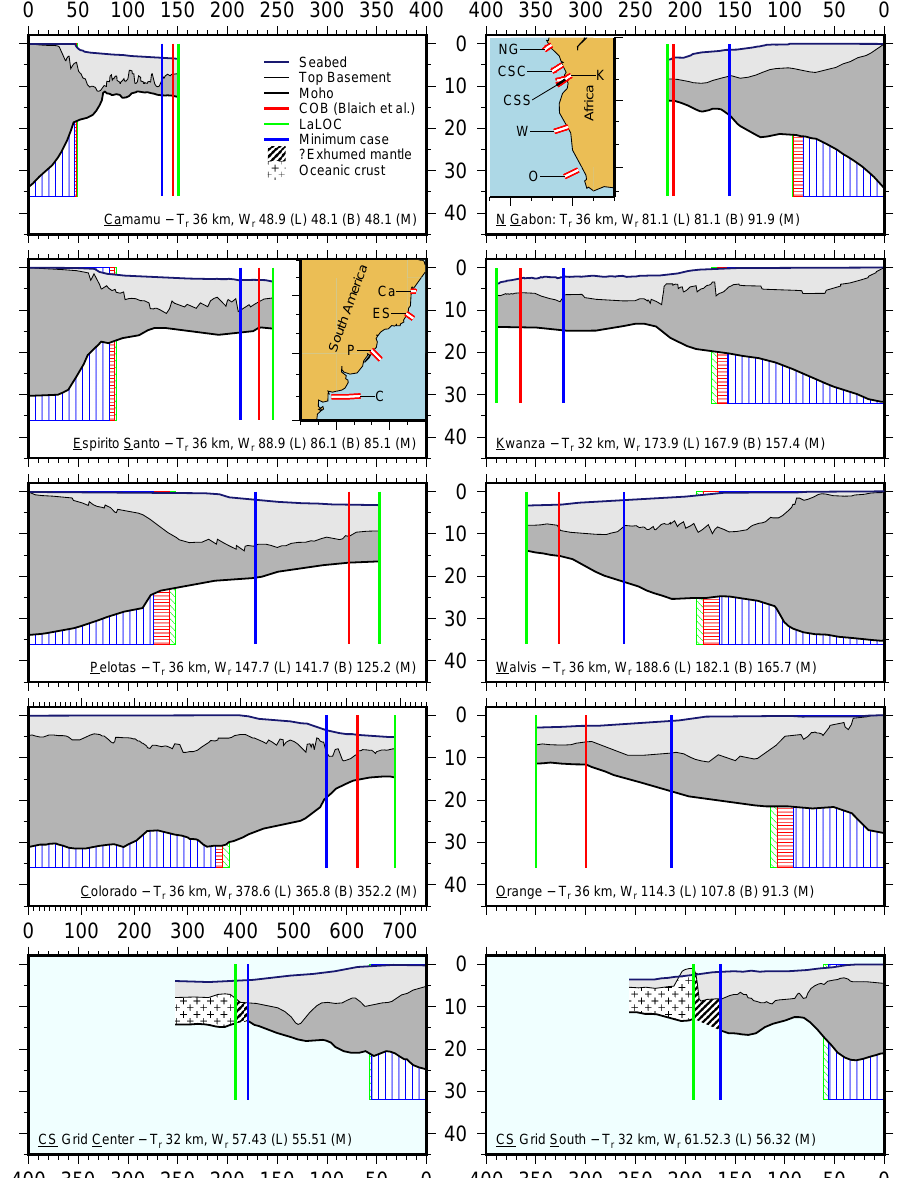
Fig. 4. Margin cross sections and area balancing based on Blaich et al. (2009, 2011), and our synthesised data based on depth-migrated and gridded CongoSPAN data along various segments of the conjugate South Atlantic margins. T r : restored thickness. Extent of continental crust used for area balancing: L – LaLOC (maximum estimate, landward limit oceanic crust); M – minimum estimate (conservative); B – COB based on Blaich et al. (2009, 2011). Note that our interpretation of the CongoSPAN data (CS Grid north and south sections) includes a zone where no Moho could be identified on seismic data, which is here tentatively interpreted as exhumed mantle. Further note the difference in length of the Colorado Basin section. The profile data are available as plain text files at http://datahub.io/en/dataset/southatlanticrift.